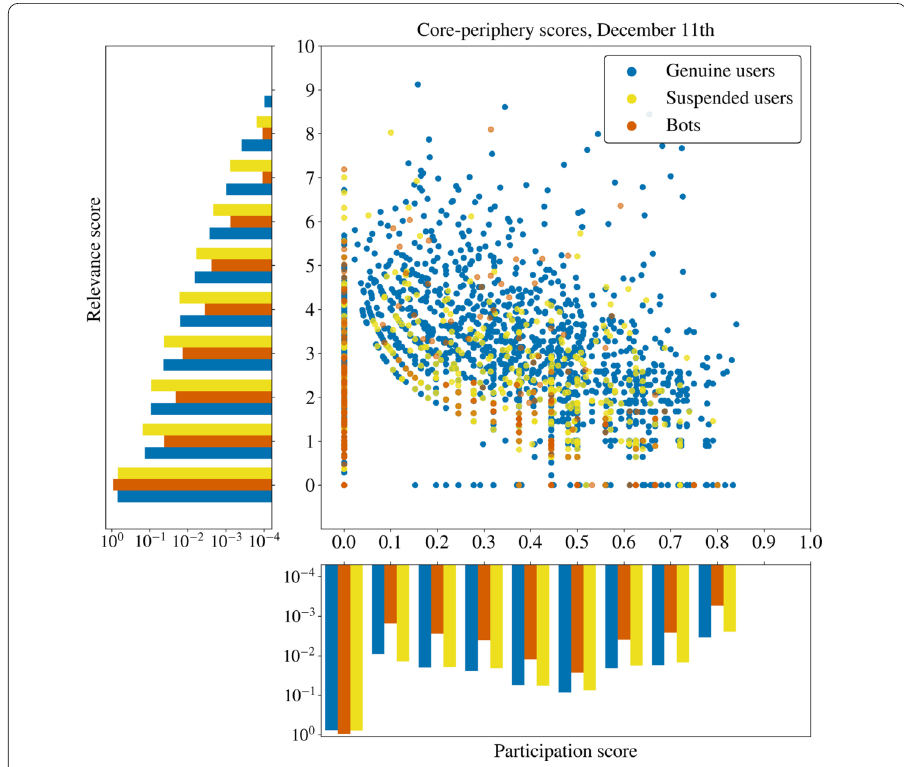
Figure 4 A scatter plot of the core-periphery scores with different colors for bots, suspended users and humans, for the network of retweets among users the day before the election. The histograms on the bottom and left of the scatter plot show the marginal distributions of the relevance score and participation score. While automated accounts are concentrated on lower values of presence and participation scores, suspended and genuine users have a flatter distribution, even if a peak on the lower values is still present. Bots are more inclined to retweet accounts in their community (low participation score) and moreover focus their activity on few users (low relevance score). The difference in core-periphery scores can be observed throughout the period we considered, see Appendix B for